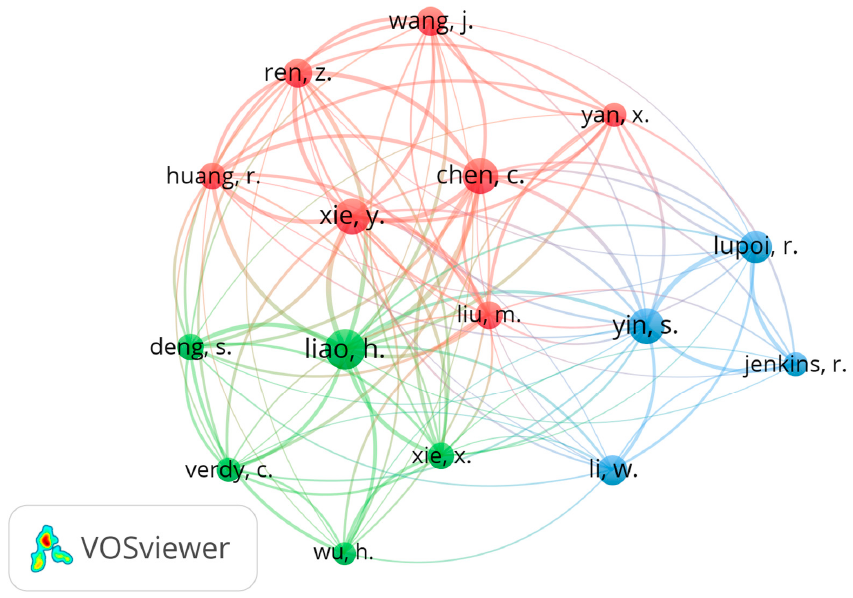
Figure 18. Authors’ collaboration. Minimum of 10 articles per author.